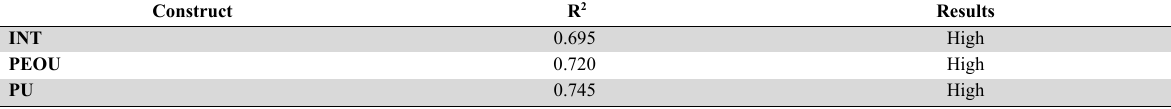
R 2 of the endogenous latent variables